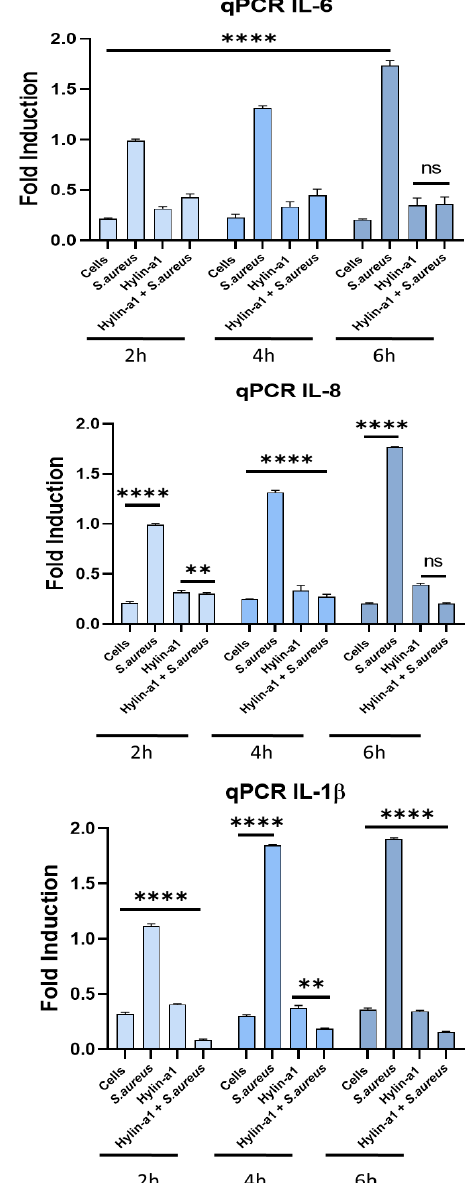
Figure 9. Real-time PCR. Evaluation of pro-inflammatory cytokines. ( A ) Evaluation of IL-6 expression; ( B ) evaluation of IL-8 expression; ( C ) evaluation of IL-1β expression. **** p < 0.0001; ns: non-significant.